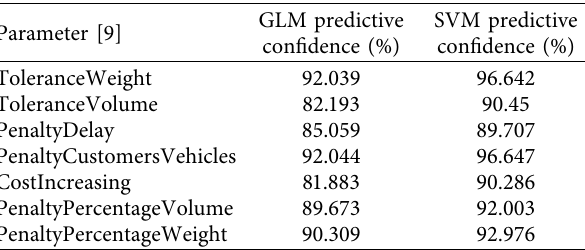
Table 6: Attribute importance results.